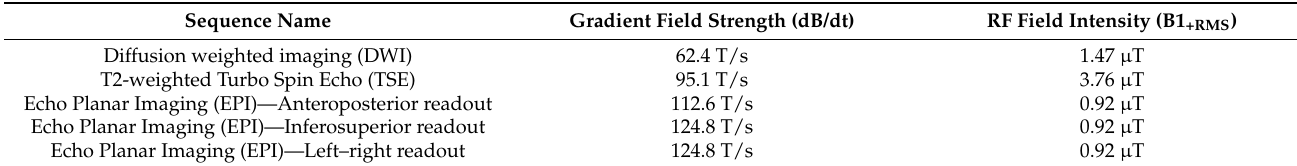
Table 1. Key parameters for the pulse sequences that were used during the